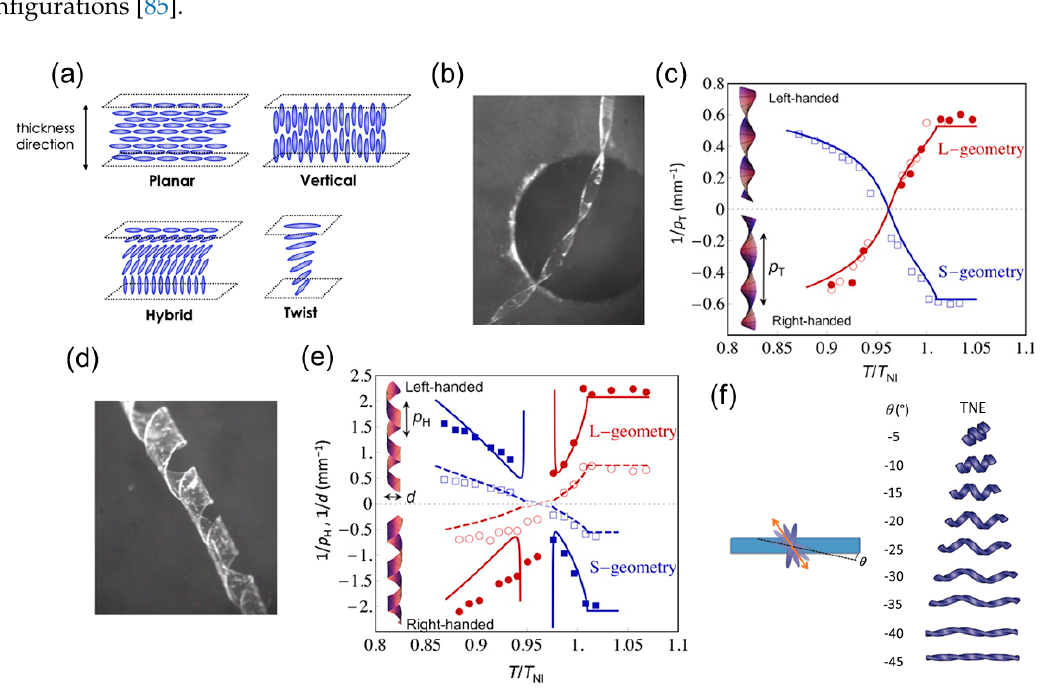
Figure 6. Nematic configurations and formation of helix/spiral induced by temperature variation. ( a ) Planar-, vertical-, hybrid-, and twist-nematic configurations of LCNs; ( b ) Formation of a helicoid ribbon from narrow TNE film at 330 K; ( c ) Inverse of the twist pitch (1/p T ) as a function of normalized temperature (T/T NI , where T is temperature and T NI is the nematic-isotropic transition temperature). Positive and negative p T indicate left- and right handedness, respectively. Red circles and blue squares represent data of L- and S-geometry, respectively. Filled symbols indicate data obtained in cooling processes and open in heating processes. Theoretical predictions are represented by lines; ( d ) Formation of a spiral ribbon from the wide TNE film at 336 K; ( e ) Inverse of the helical pitch (1/p h ) and the diameter (1/d) as a function of T/T NI . Positive and negative p H indicate left- and right handedness, respectively. Red circles and blue squares represent data of L- and S-geometry, respectively. Filled symbols are data for 1/d and open symbols are data for 1/p h . Theoretical predictions are represented by lines; ( f ) Various simulated helical shapes corresponding to different off-axis angles. Simulation performed by Vianney Gimenez-Pinto. ( θ ). Figures reprinted from: ( a ) [85], with permission from Elsevier; ( b – e ) [31]; ( f ) [32], with permission from the American Physical Society.